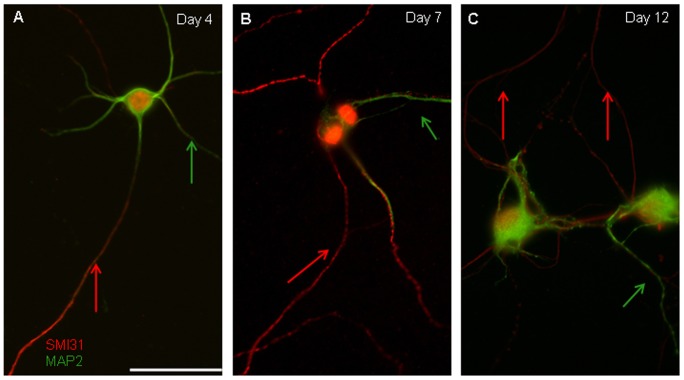
Hippocampal neurons are differentiated and present distinct morphology for both the axon and dendrites.Dendrites have shorter process and taper more gradually (arrows), while axons display a long, narrow process with minimal tapering (arrows in all figures). (A–C) Expression of phosphorylated neurofilaments SMI-31 (red) and microtubule-associated protein MAP2 (green) (A) Double-label immunofluorescence of SMI-31 (red) and MAP2 (green) at 4 DIV (days in vitro). Dendrites (MAP2) are shorter with gradual tapering projections whereas axon (SMI-31) stain display long narrow processes. (B) Double-label immunofluorescence of SMI-31 (red) and MAP2 (green) at 7 DIV. (C) Double-label immunofluorescence of SMI-31 (red) and MAP2 (green) at 12 DIV. Bar is 50 µm.